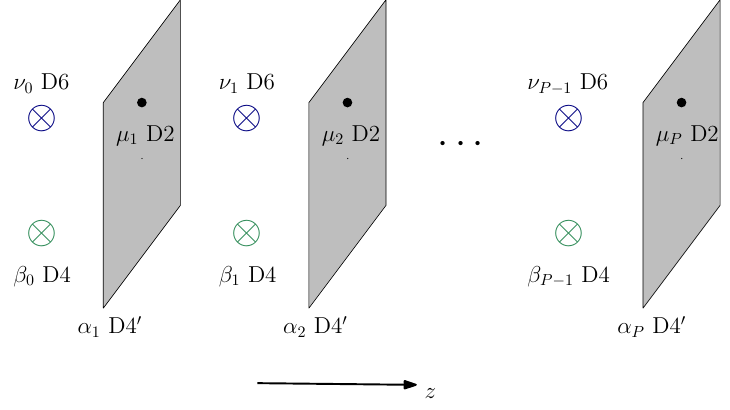
Figure 3 . Hanany-Witten brane set-up associated to the quantised charges of the solutions.